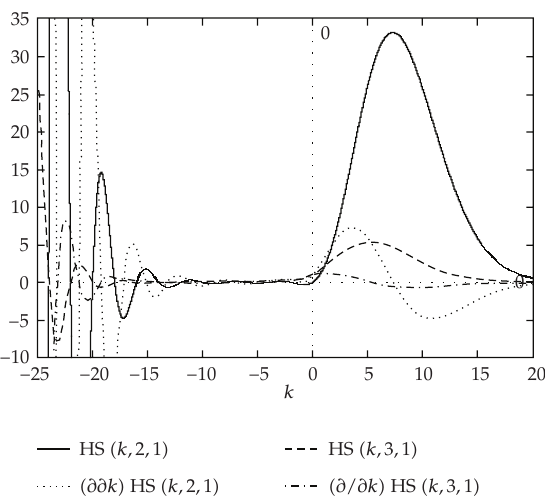
Figure 3: The parallel presentation of the orginal hyperspherical functions (cid:2) for n (cid:7) 2 and n (cid:7) 3 (cid:3) of the unit radius, and corresponding functions of their first derivatives for − 25 ≤ k ≤